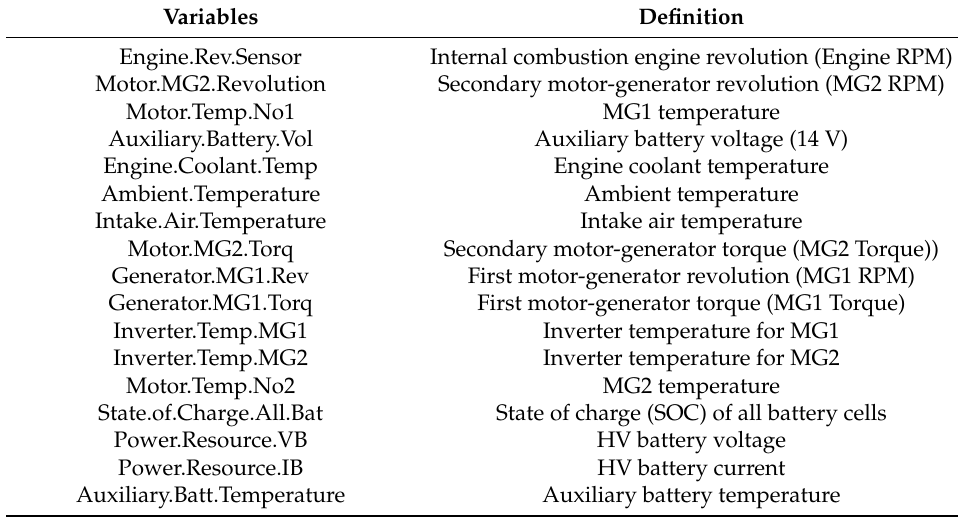
Table 2. Definition of variables obtained from Electronic Control